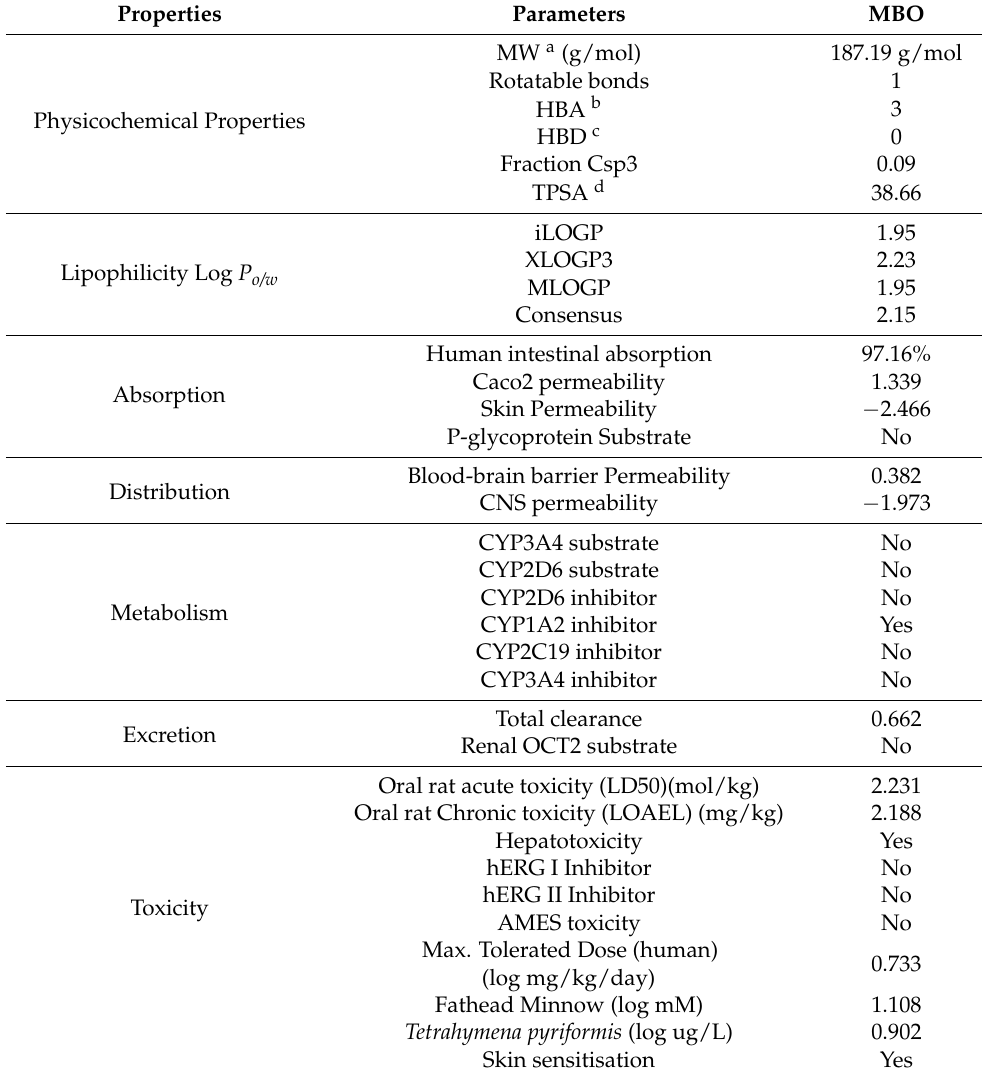
Table 5. Pharmacokinetic and ADMET values of MBO.